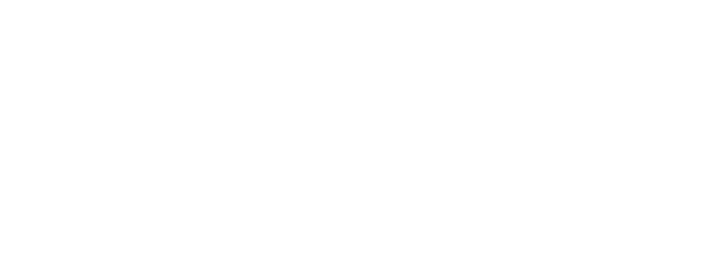
Table 1. Cut-off points to define the severity of